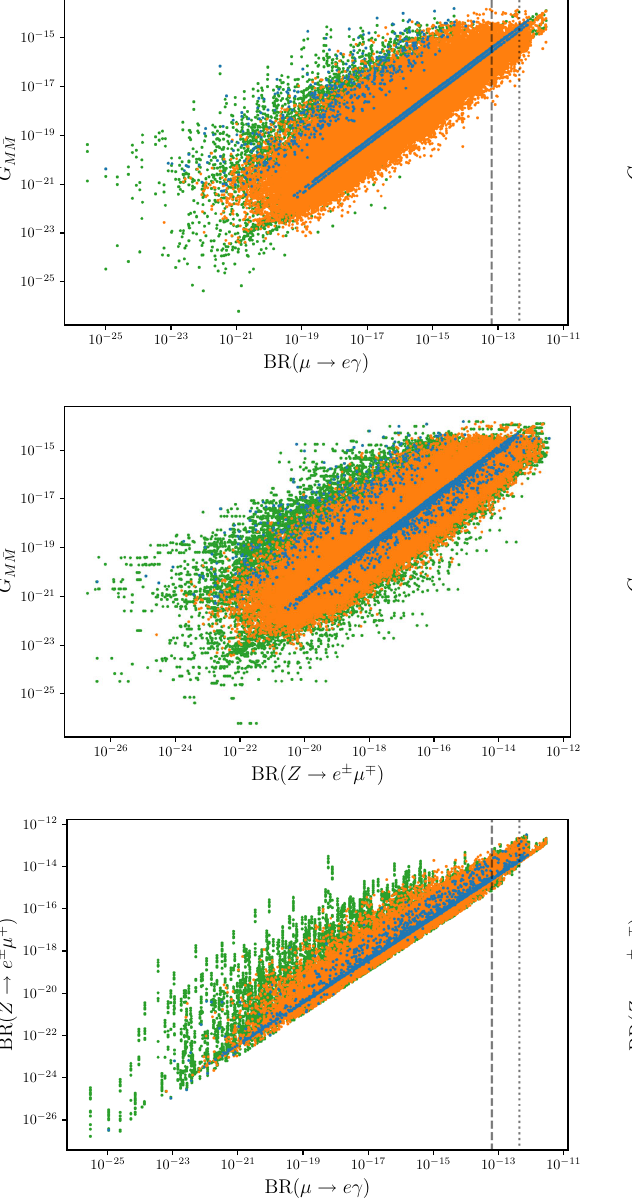
= m = 1TeV, while 4 5